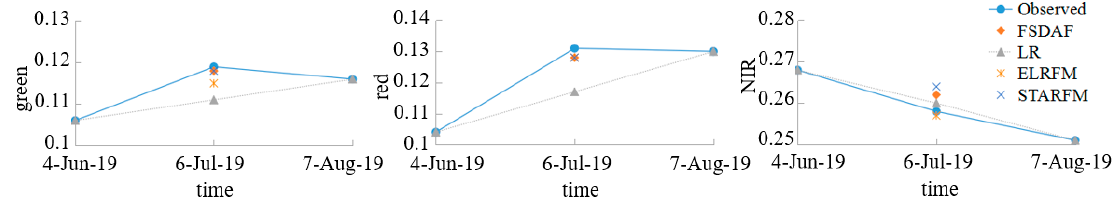
Figure 8. Average of the observed and predicted reflectance of the four methods in the green, red, and near-infrared (NIR) bands.